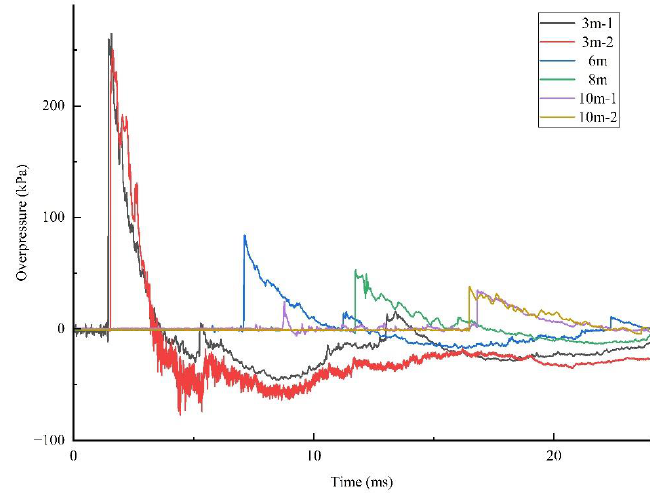
Figure 5. Shock wave overpressure curves of a stationary charge explosion. Table 3. Shock wave pressure parameters of a stationary charge explosion.